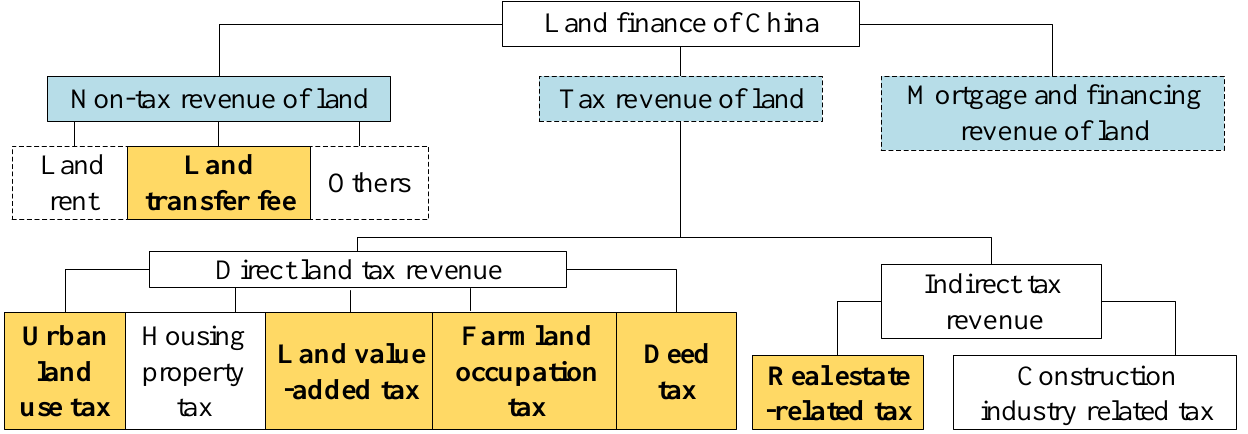
Figure 2. The composition of the measurement of land finance.